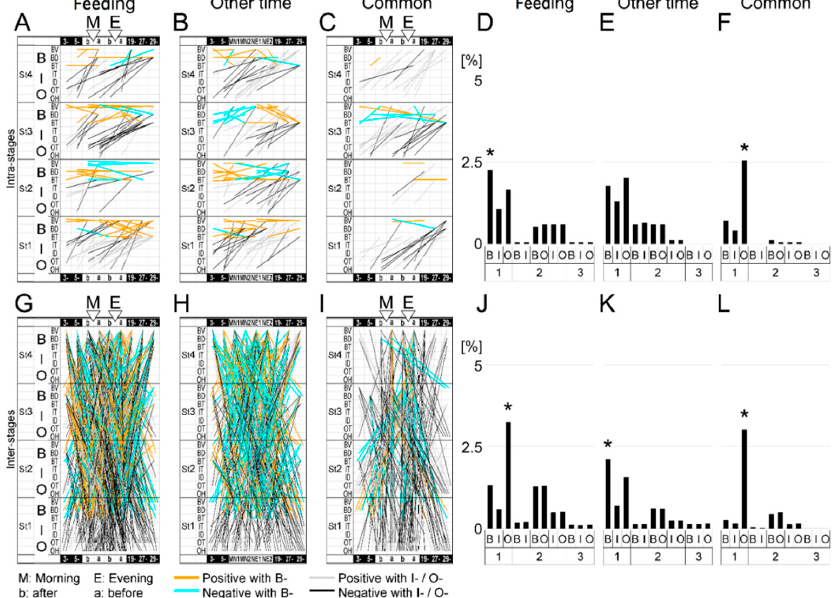
Figure 6. Correlation vectors among B-, I-, and O- variables of four age stages by linear mixed models (LMMs). Specific correlations to “feeding”, “other time” and “common” in the “intra-stage” analysis ( A – C ) and “inter-stage” analysis ( G – I ) based on LMMs followed by conditional Akaike information criterion (cAIC) to select the best fitting models are shown. Each vector indicates the relationship between an explanatory (earlier end in the time series) and response (later end in the time series) variable, and its color is categorized by the combination of the category of the variables, as shown at the bottom. Two or more vectors to one response variable from explanatory variables at same time and stage represent a complex explanation in one regression. The percentage of total explanatory variables’ number per single B-, I-, and O- indices or a combination of them are shown in each specific correlation pattern ( D – F , J – L ). * p < 0.05 by residual analysis following Pearson’s chi-square